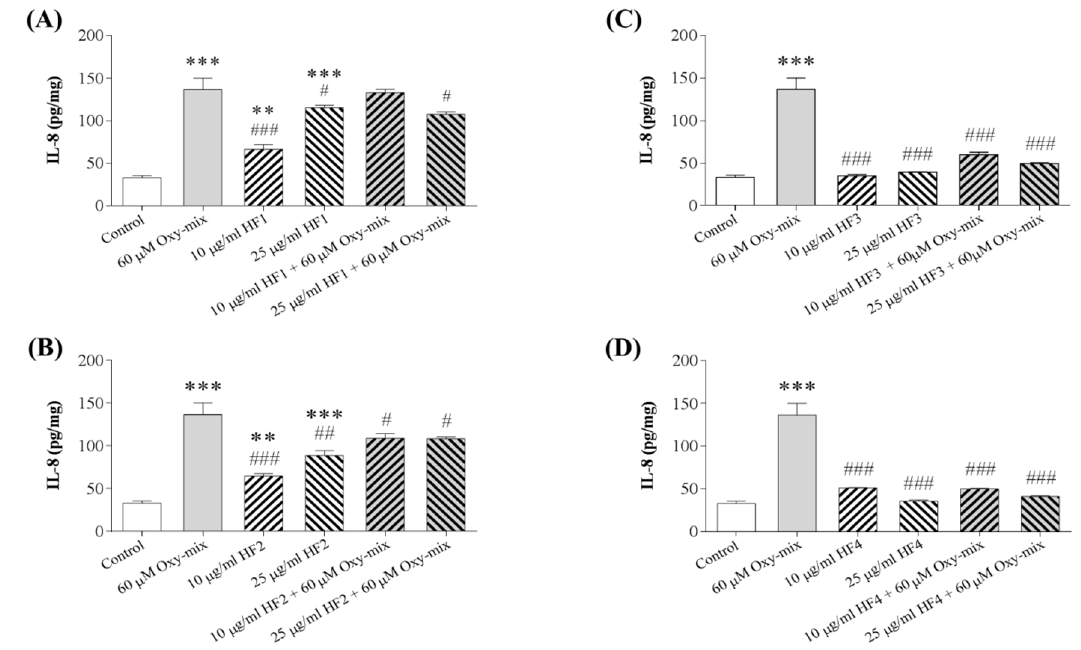
Figure 4. HF3 and HF4 prevent IL-8 cell release induced by oxysterol treatment. Differentiated CaCo-2 cells were pre-treated with 10 or 25 µg/mL HF1 ( A ), HF2 ( B ), HF3 ( C ) or HF4 ( D ) for 1 hour, then incubated with 60 µM Oxy-mix for 24 hours. IL-8 cell release in the incubation medium was considered as a marker of inflammation. Cytokine was evaluated by ELISA test and was expressed as pg/mg proteins/mL cell incubation medium. HF3 and HF4 were able to fully prevent IL-8 production with both 10 and 25 µg/mL concentrations. IL8 was already increased in the medium from the cells treated with HF1 and HF2 and not with Oxy-mix, while cytokine basal levels were not affected by HF3 or HF4. Data are reported as means ± SD of three experiments performed in triplicate. One-way analysis of variance (ANOVA) associated with Bonferroni’s multiple comparison post-test was adopted: significantly different vs. controls: ** p < 0.01 and *** p < 0.001; significantly different vs. Oxy-mix: # p < 0.05, ## p < 0.01 and ### p < 0.001.